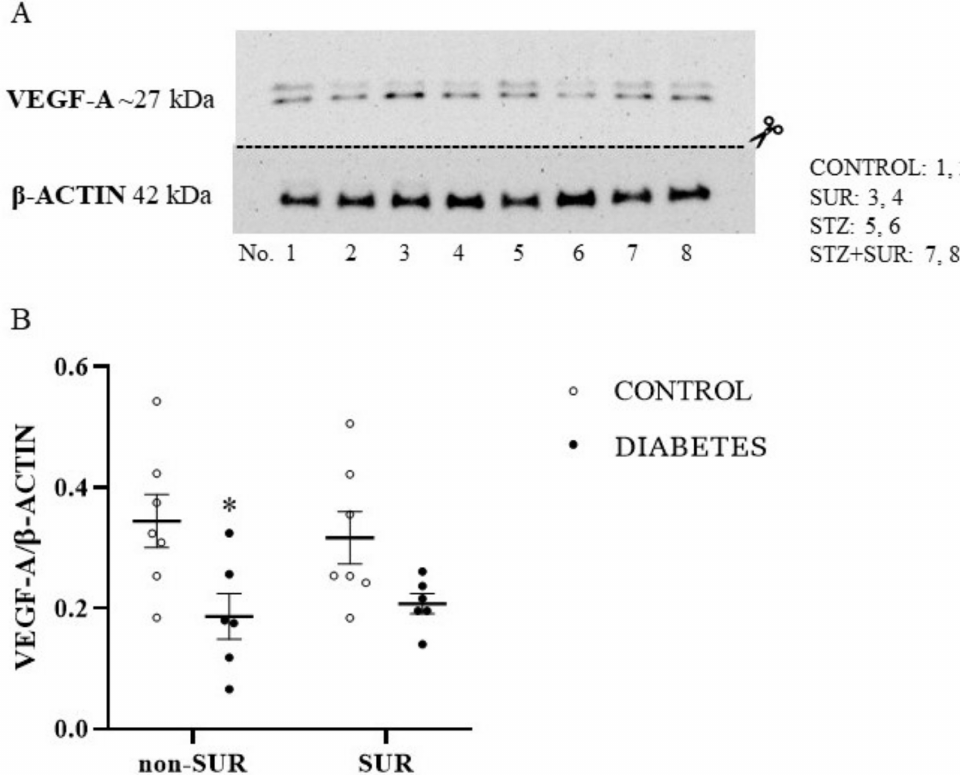
Figure 3. The effects of suramin on VEGF-A protein expression in glomeruli isolated from non- diabetic and diabetic rats. Suramin (SUR, 10 mg/kg) or saline (non-SUR) were injected into non- diabetic rats (CONTROL) and streptozotocin-induced diabetic rats (DIABETES) on days 0 and +7 after streptozotocin or citrate buffer injection on day –7. ( A ) Densitometric scans: relative optical density expressed as the VEGF-A/ β -actin ratio. The results of VEGF-A/ β -actin expression are presented as single data points with mean values ± standard error of the mean. Statistical significance: * p = 0.0023 vs. control non-SUR (two-way ANOVA). ( B ) Representative immunoblot of VEGF-A protein expression in isolated glomeruli; lanes 1, 2: non-diabetic suramin untreated (CONTROL); lanes 3, 4: non-diabetic suramin treated (SUR); lanes 5, 6: diabetic suramin untreated (STZ); lanes 7, 8: diabetic suramin treated